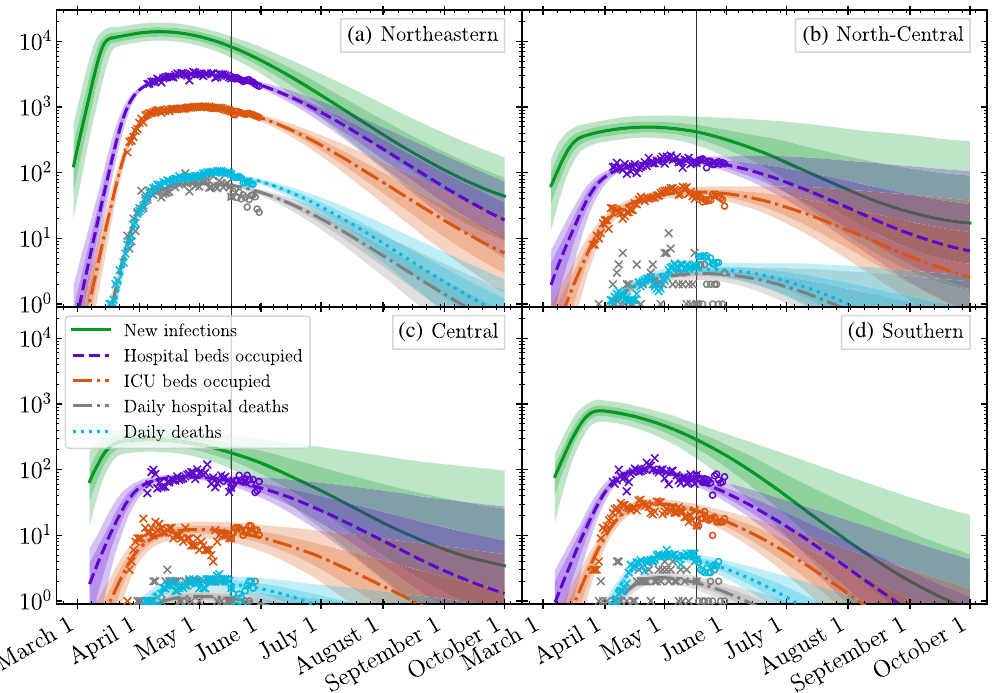
FIG. 4. Fits and predictions of our model under the baseline scenario with the stay-at-home order and social distancing maintained until October 1, 2020. The model is calibrated with data (crosses) through April 20, 2020 separately for each of the four super-regions of the state: (a) North-Central, (b) Northeast, (c) Central, and (d) Southern. The data from later dates (open circles) were not used in our fits, allowing a comparison of model predictions with real-world observations. Solid lines denote the median model prediction at a given time. The shaded regions denote the 68.4% (darker shading) and 95.6% (lighter shading) confidence intervals, obtained as quantiles of an ensemble of forward simulations, which sample the posterior distribution over model parameters. We depict the daily incidence of new infections (green, solid), the number of occupied hospital beds by confirmed or tentative COVID-19 patients (purple, dashed), the number of ICU beds occupied by confirmed COVID-19 patients (orange, dot-dashed), and total daily deaths of COVID-19 patients (light blue, dotted). We remove reporting artifacts by plotting daily-death data smoothed by a 7-day running